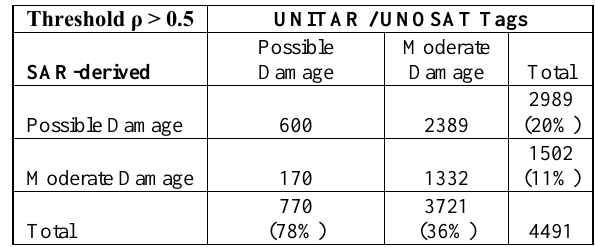
Table 2. Comparison of UNITAR / UNOSAT and SAR-derived damage tags at ten locations devastated by Typhoon Rai.